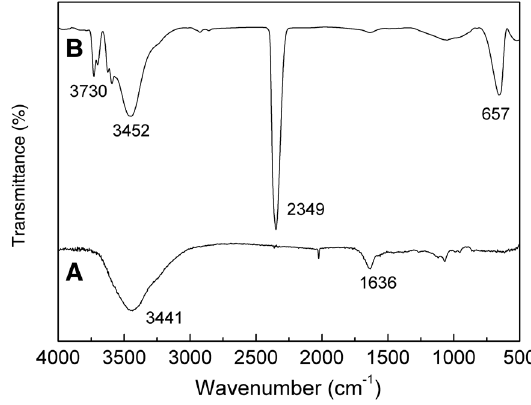
Figure 2 FTIR spectra of CNT. (A) Raw CNTs, (B) CNT-KH550.